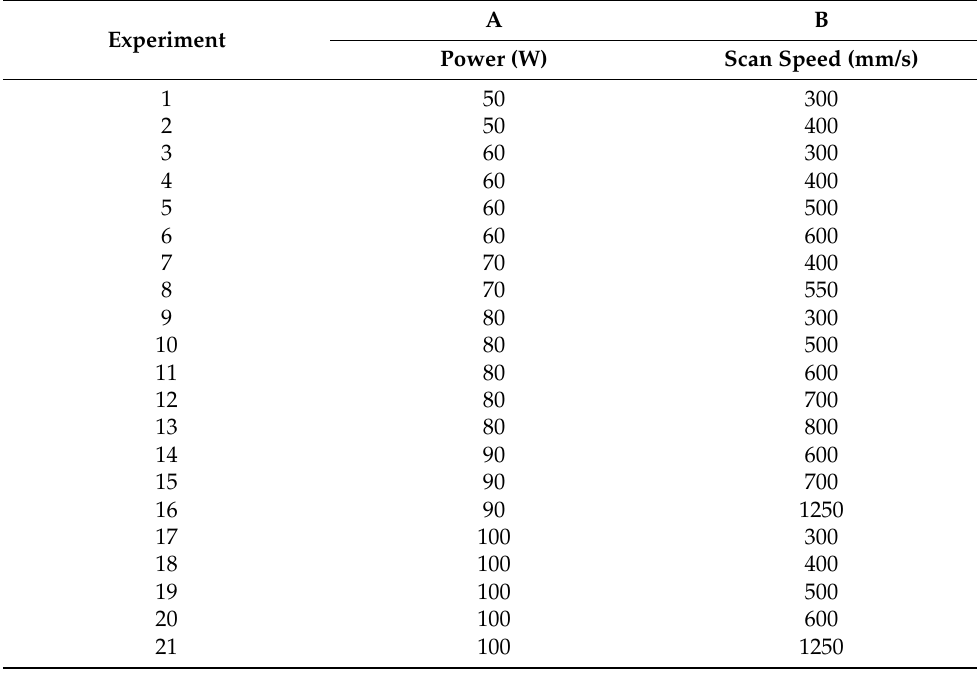
Table 1. Plan of experiments for the fabrication of Ti6Al4V thin-walled